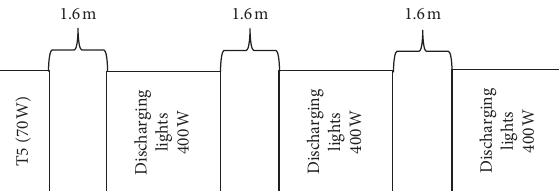
Figure 6: The tunnel lighting configuration of one 75W T5 fluorescence light followed by three 400W discharging lights with sodium lamp for each traffic lane is repeated from the entry to the end of threshold